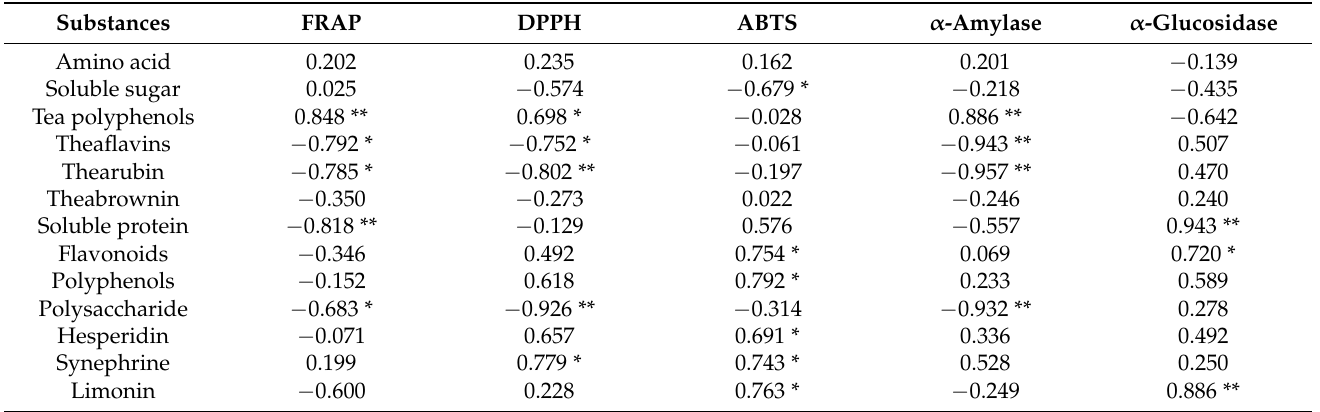
Table 6. Correlation analysis between ODT functional activities and chemical